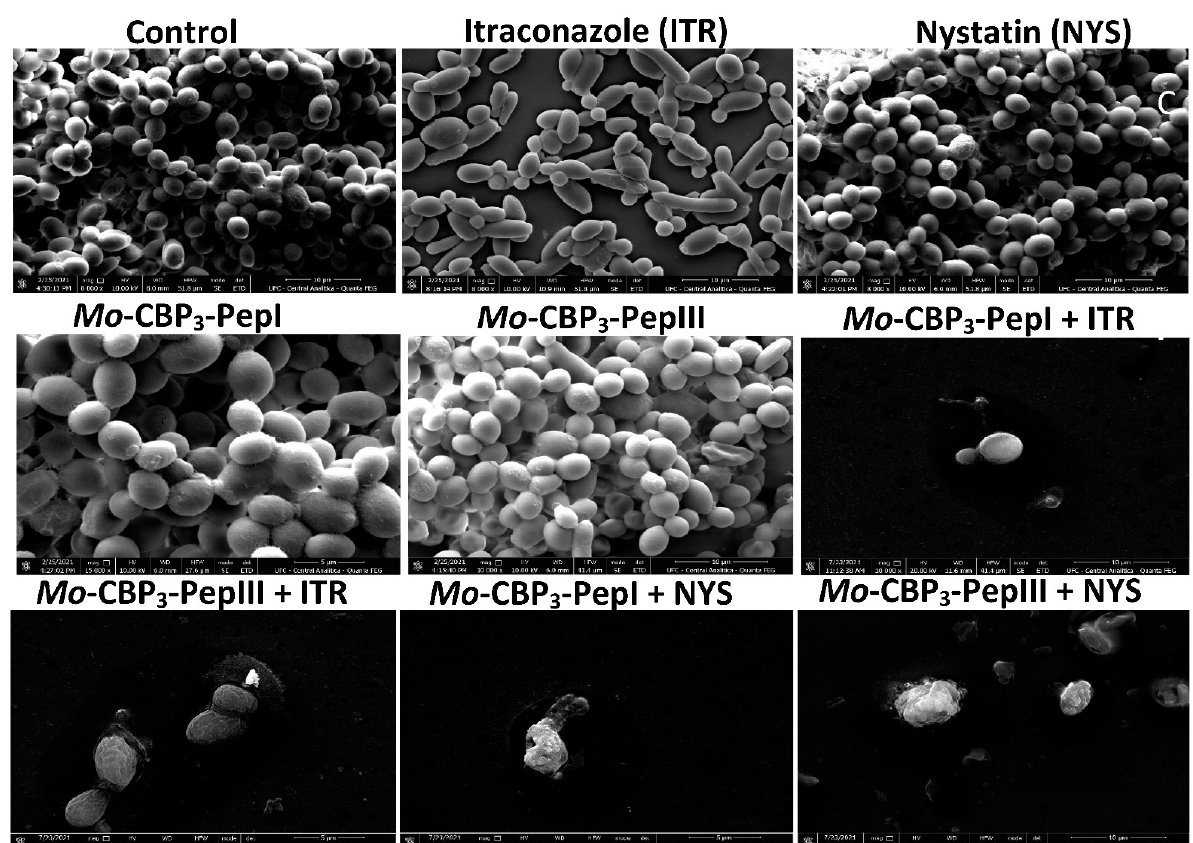
Figure 3. SEM images showing C. parapsilosis biofilms after treatment with ITR, NYS, Mo -CBP 3 -PepI, Mo -CBP 3 -PepIII, and their combinations. Control: DMSO-NaCl solution.